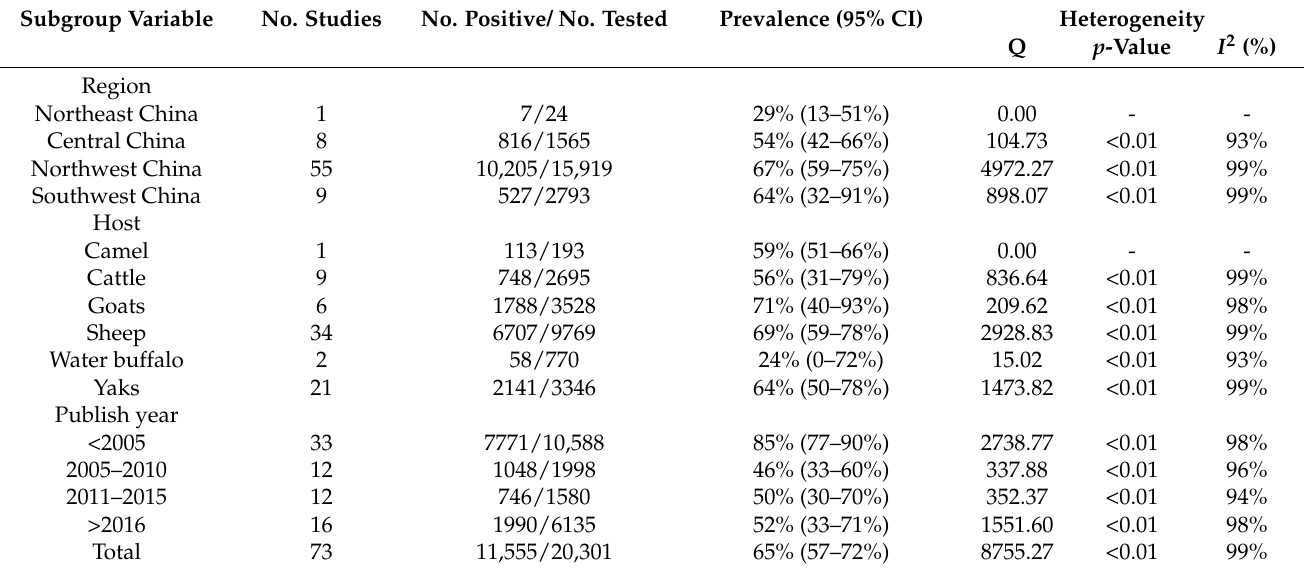
Table 3. Pooled prevalence of subgroup analysis (region, host and publish year) for Sarcocystis infection in ruminants in mainland